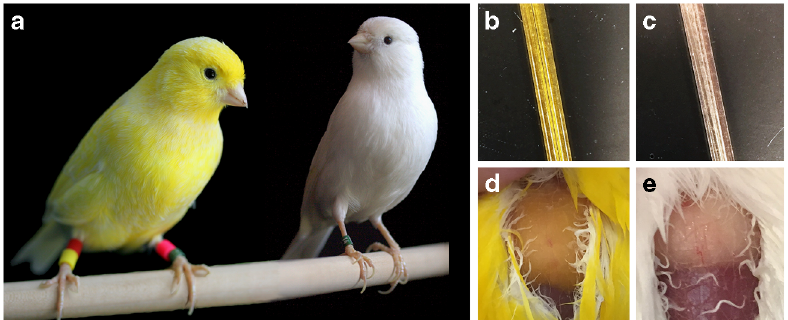
Fig. 1 Comparisons of tissue coloration of yellow (Y) and white recessive (WR) breeds of canaries. a Y canaries grow bright yellow feathers; WR canaries grow pure white feathers. b Y canaries circulate yellow plasma and c WR canaries circulate colorless plasma. d The subcutaneous fat pads of Y canaries are yellow; e the fat pads of WR canaries lack yellow